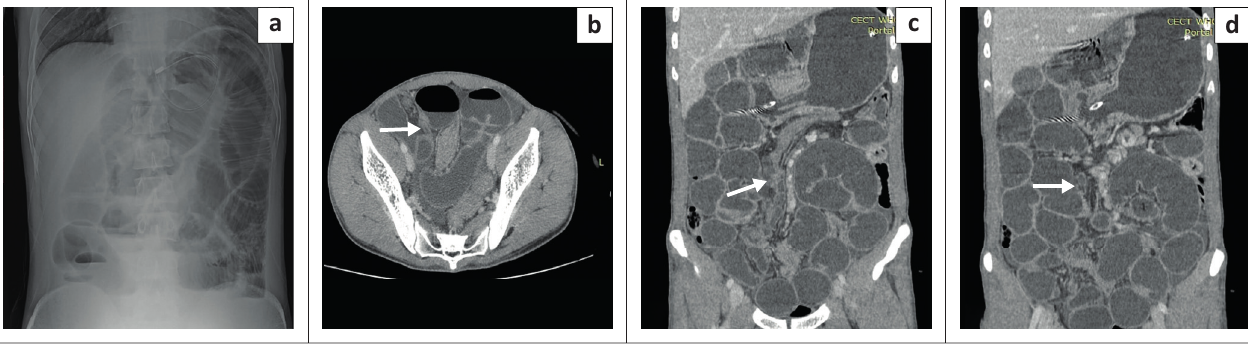
FIGURE 2: X-ray abdomen (a) erect anteroposterior view shows dilated gas-filled bowel loops with multiple air-fluid levels. Contrast enhanced computed tomography in the axial (b) and coronal (c, d) planes shows dilated small bowel loops with an inflamed Meckel’s diverticulum (white arrows) arising at the level of the transition point.